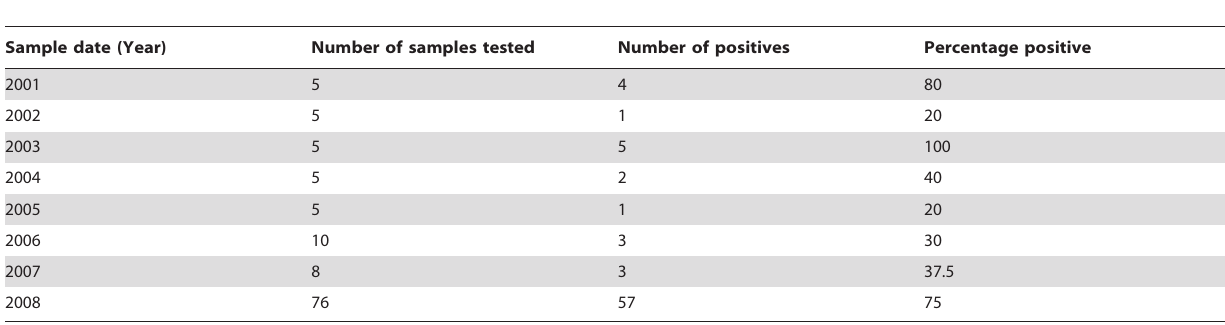
Table 1. Serological analysis for EEV antibodies in Israeli equine sera